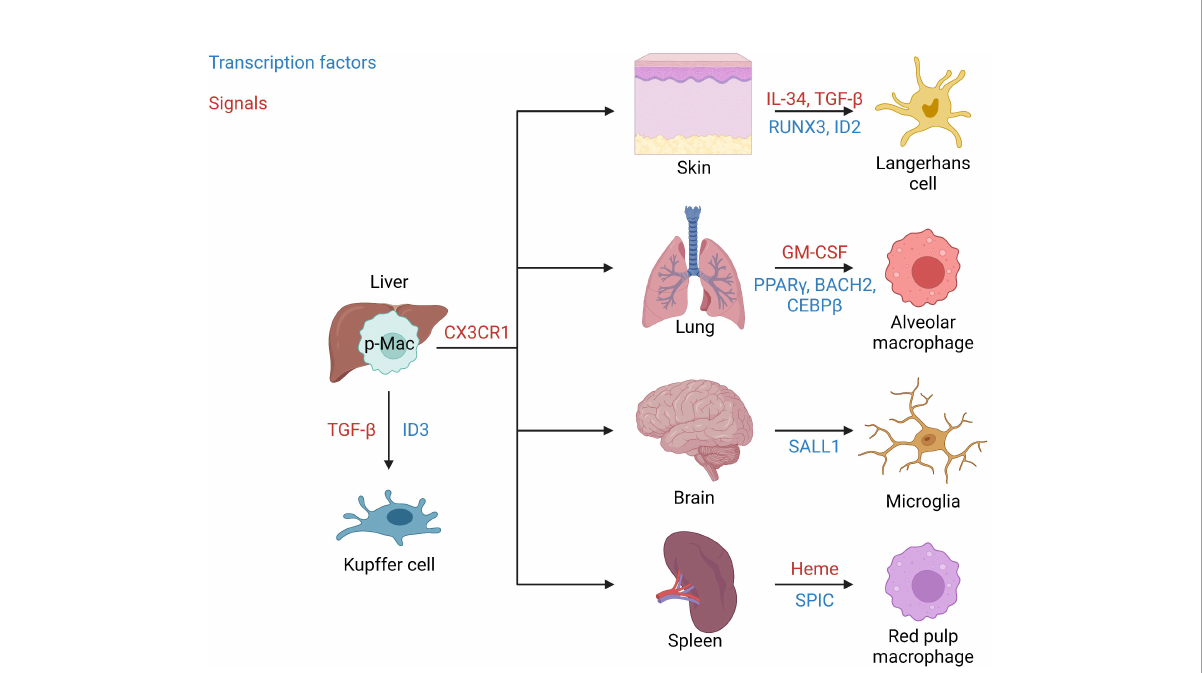
FIGURE 1 Tissue seeding. Signals and transcription factors involved in seeding of well-known tissue-resident macrophages from fetal liver p-Macs. Migration from the liver occurs in a CX3CR1 dependent manner. In the skin IL-34 and TGF- b induce the transcription factors RUNX3 and ID2 to generate Langerhans cells. In the lung GM-CSF induces the transcription factors PPAR g , BACH2, and CEBP b to produce alveolar macrophages. In the brain/central nervous system, microglia are generated in response to the induction of the transcription factor SALL1. Red pulp macrophages in the spleen are produced in response to Heme and the transcription factor SPIC. Finally, in the liver Kupffer cells are generated in response to TGF- b and the transcription factor